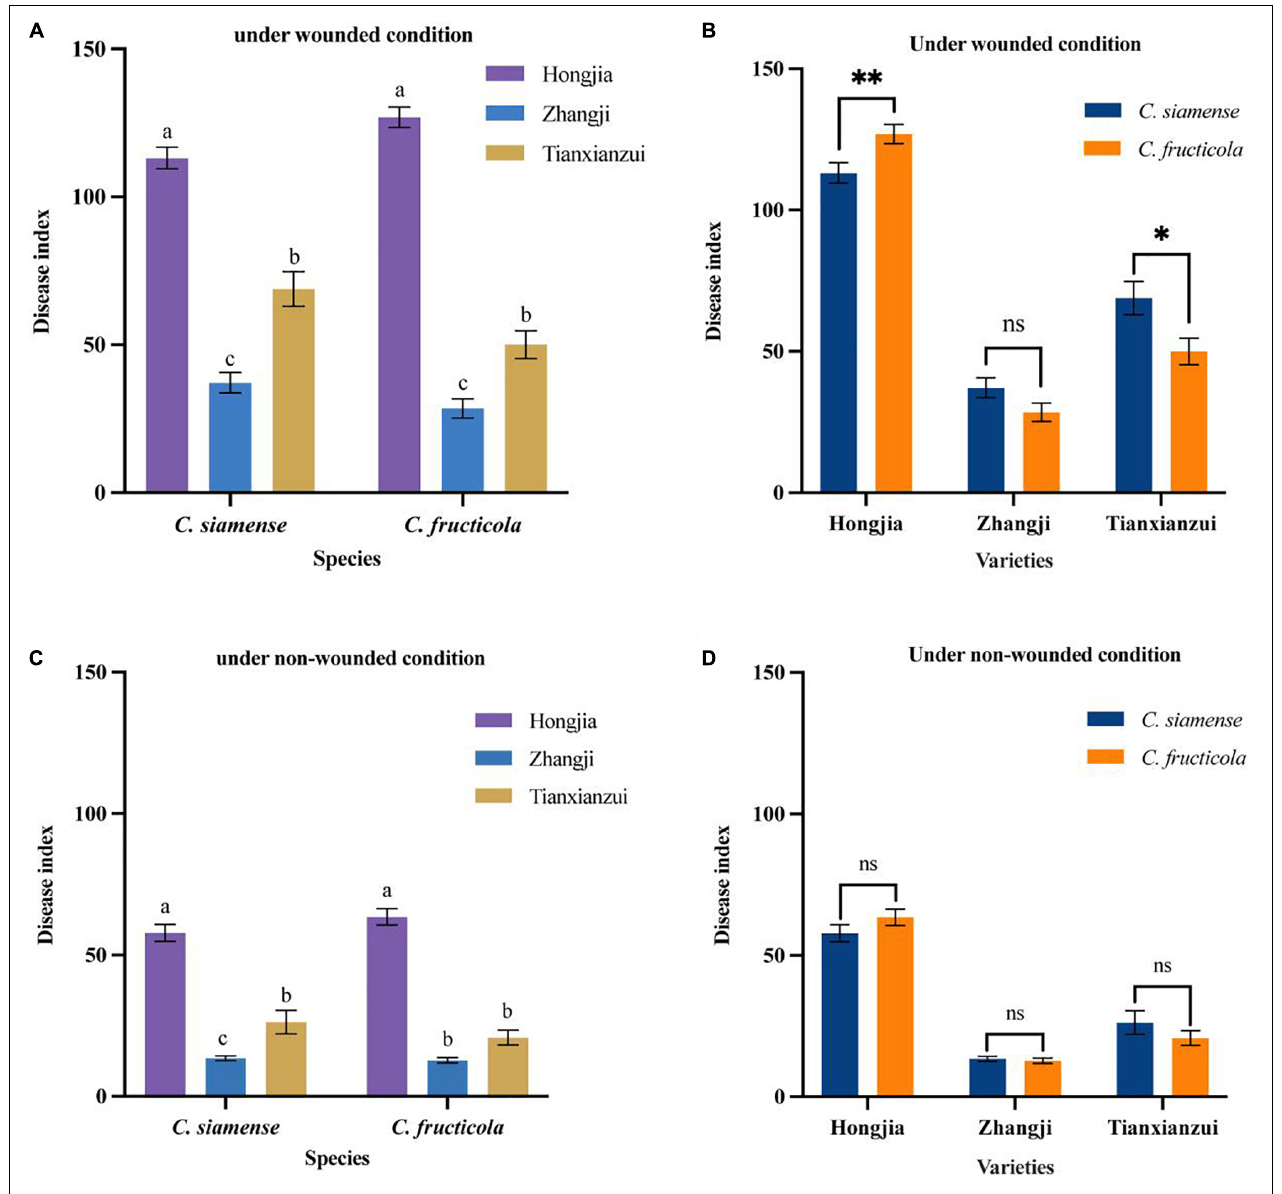
FIGURE 4 | Pathogenicity of Colletotrichum fructicola and C. siamense to different varieties of crown of strawberry. ∗ P = 0.05, ∗∗ P = 0.01, ns = not significant. (A,B) To strawberry crown of different varieties under wounded condition. (C,D) To strawberry crown of different varieties under non-wounded condition. Values with the same letters were not statistically different ( P > 0.05) according to the least significant difference (LSD)